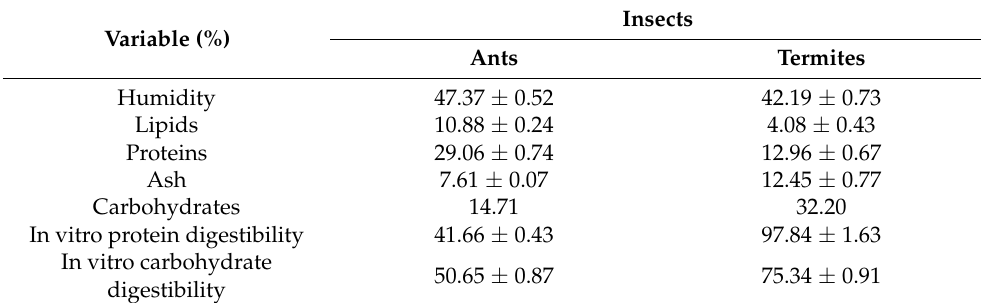
Table 1. Nutritional assessment and in vitro digestibility of ant ( Acromyrmex lundi ) and termite samples ( Cortaritermes fulviceps ) offered to lesser anteaters ( Tamandua tetradactyla ) during the behavioral